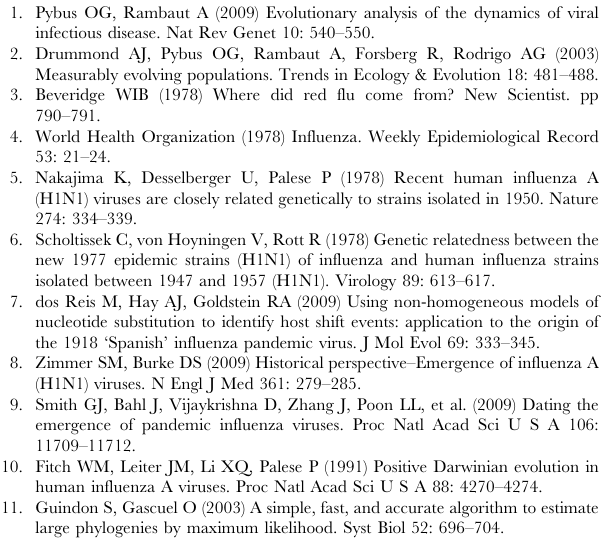
Table S7 Bayes factor model test on PB1 segment.